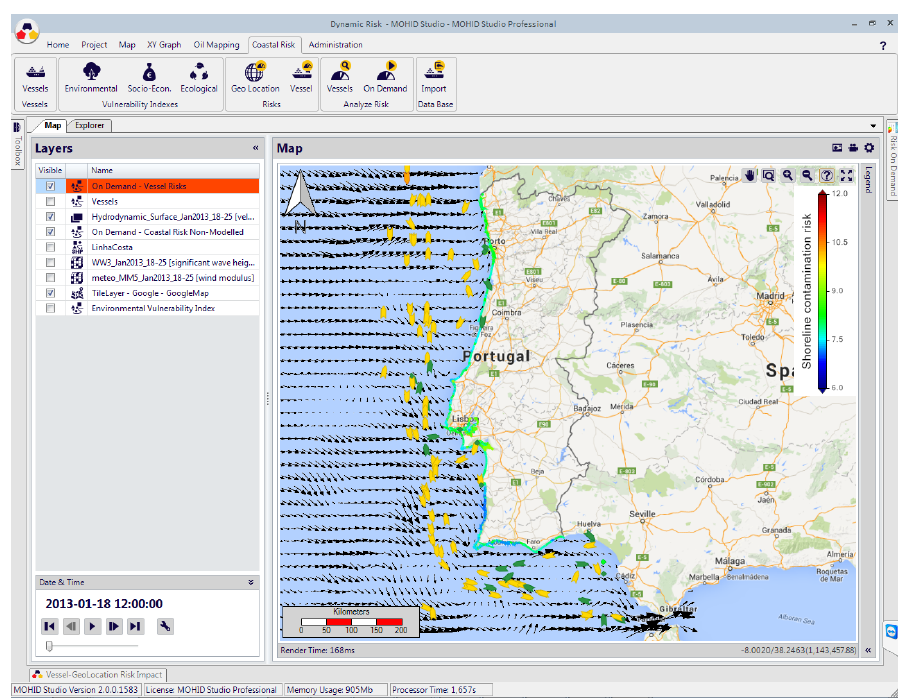
Figure 3. GUI layout, with simultaneous visualization of ship incident risks, shoreline contamination risks, surface water velocity and Google map layer. Ship incident risk colours are presented in categorized view (green, yellow, orange and red).